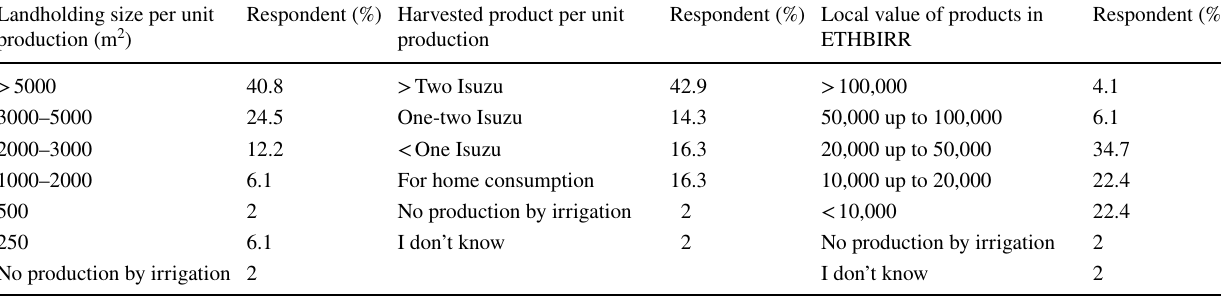
Table 12 Irrigated crop area and harvested product per unit production with local values Landholding size per unit production (m 2